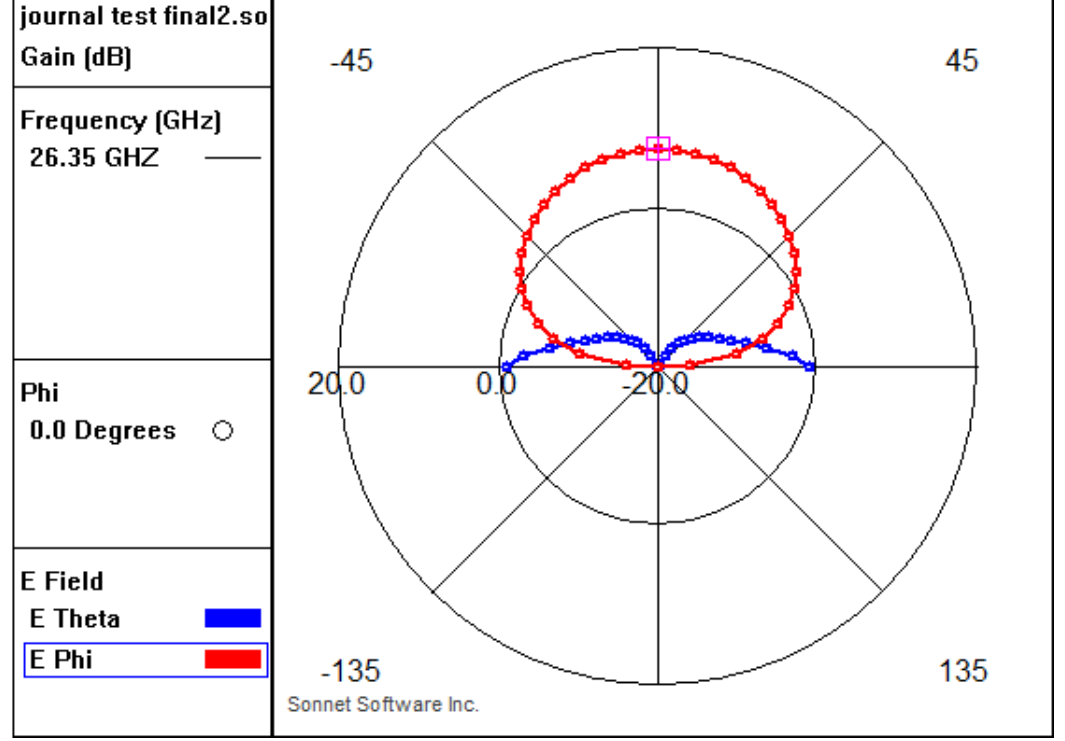
Figure 3. Gain output of the slitted inset fed butterfly-shaped microstrip patch